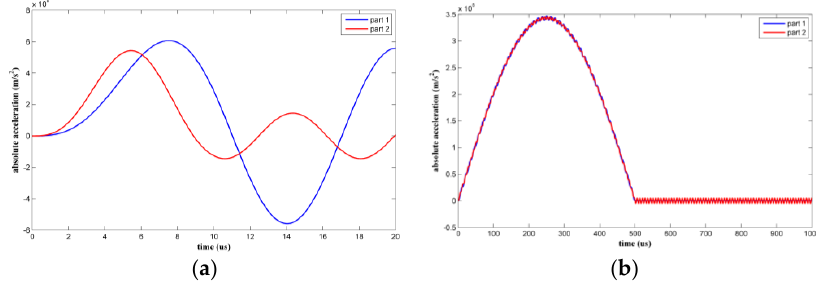
Figure 8. Absolute acceleration response of each part of the suspended inductor with auxiliary pillar: ( a ) τ = 10 μs, ( b ) τ = 500 μs. ( a ) τ = 10 µ s, ( b ) τ = 500 µ